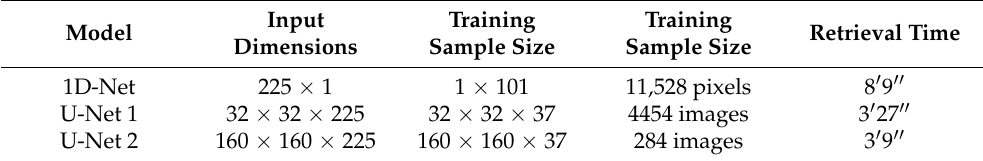
Table 2. Sample parameters for network training.